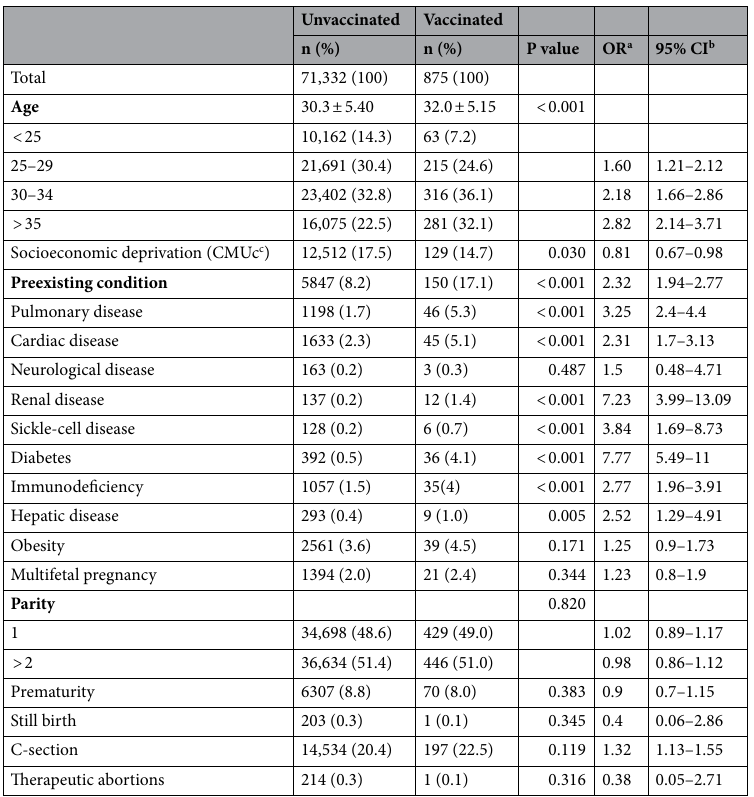
Table 1. Influenza vaccination and associated factors among pregnant women from 2009 to 2018. a OR: odds ratio calculated with Wald test. b CI: confidence interval. c CMUc: couverture mutuelle universelle complémentaire ( universal complementary healthcare